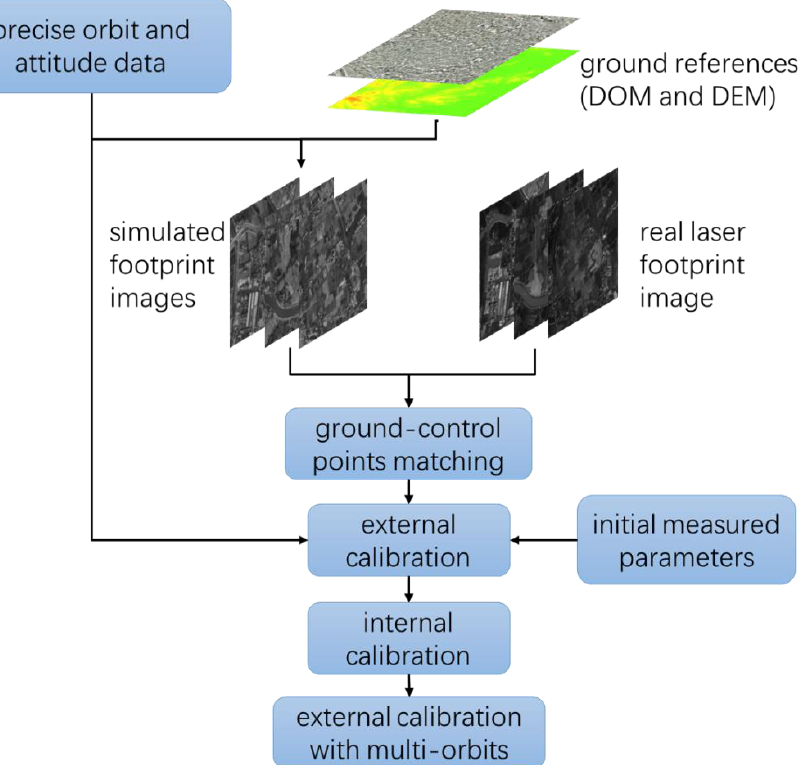
Figure 2. Calibration flow for laser footprint cameras of GF-7 satellite.